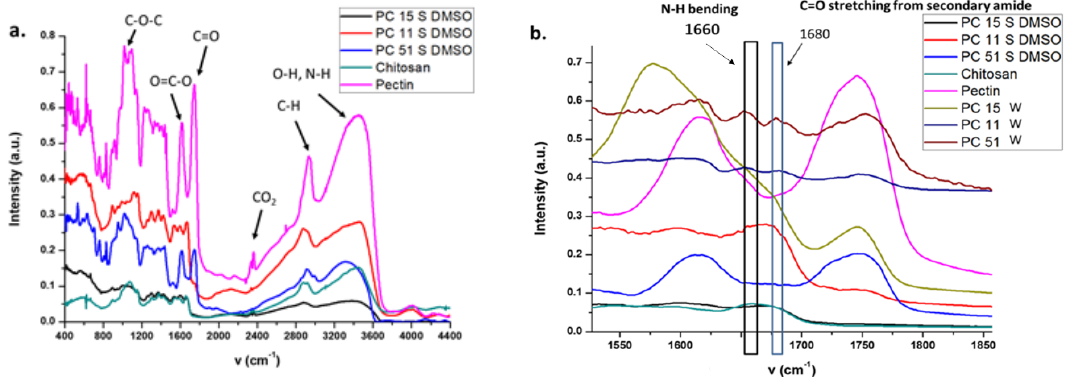
Figure 3. ( a ) Infrared (IR) spectra of pectin, chitosan, and their composites prepared in DMSO under assisted sonication, and ( b ) IR spectra of pectin, chitosan, and composites prepared in water and DMSO solvents.